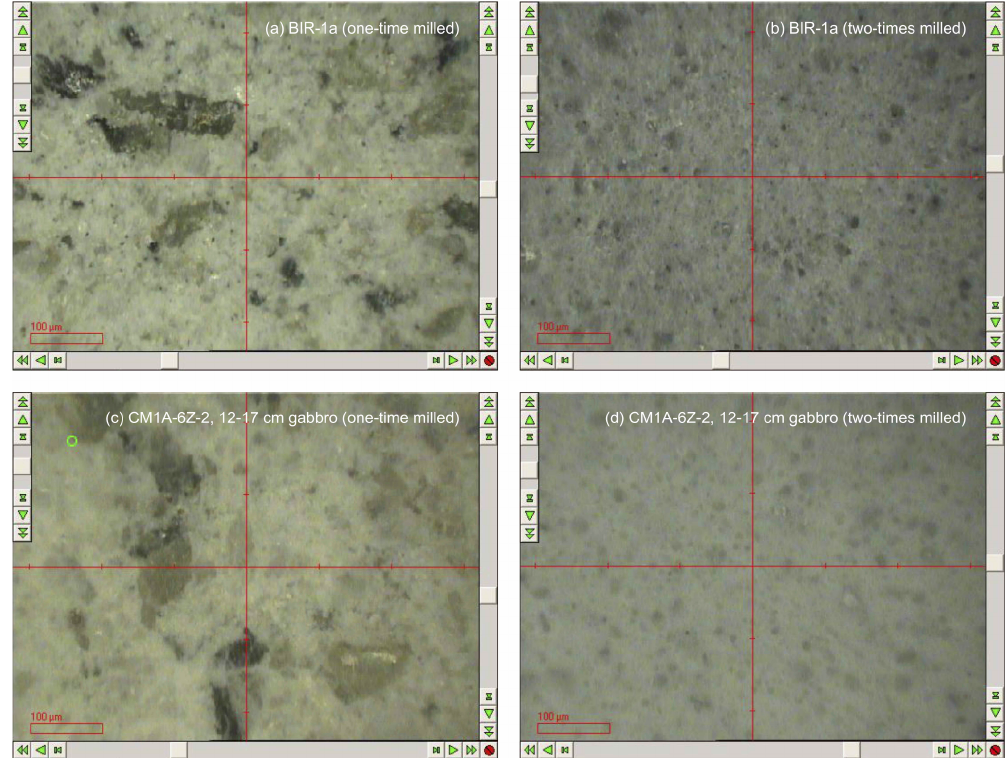
Figure 2. Comparison of the grain sizes in pressed powder pellets before (a, c) and after (b, d) the second step milling for the reference material BIR-1a (a, b) and for the gabbro sample CM1A-6Z-2, 12–17cm from the OmanDP Hole CM1A (c, d) (modified from Fig. F52, Kelemen et al., 2020). The minimum laser spot size that could be parameterized with the laser ablation system used on-board the D/V Chikyu was 100µm in diameter, smaller than the size of some mineral grains when samples have been milled only